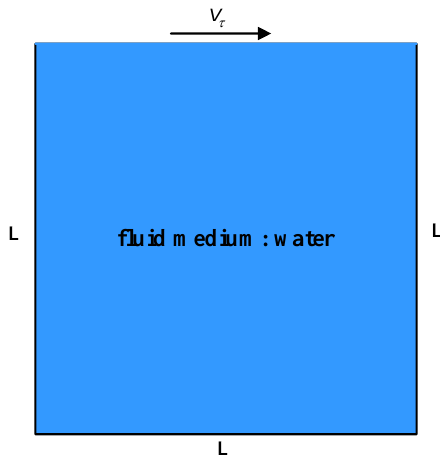
Fig. 2. The structure of classic shear driven cavity.